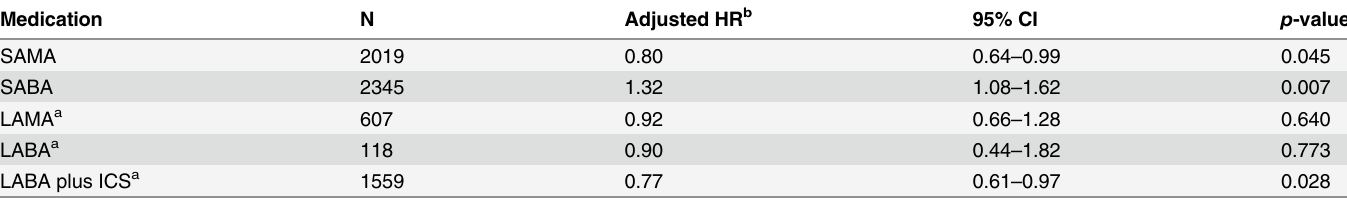
Table 3. Adjusted Hazard Ratios for Stroke (Included Ischemic Stroke and Hemorrhagic Stroke) between COPD Patients with or without Using the Five Categories of Inhaled Pharmacotherapy during Three-Year Follow-up (N = 10,413). Medication N